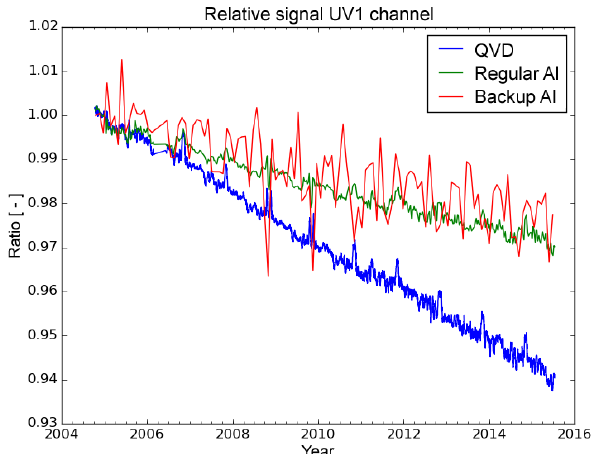
Figure 26. Relative solar signal of the UV1 channel over the mis- sion. Each data point shown for the three diffusers is a result of a spectral and spatial average over the entire channel. The higher rate of signal change from the frequently used QVD suggests degrada- tion in diffuser reflectivity caused by solar